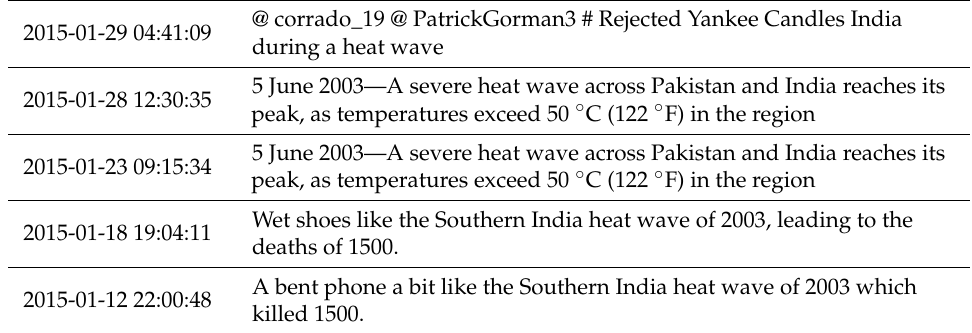
Table 2. Example Tweets containing the phrase “heat wave India” in January 2015.